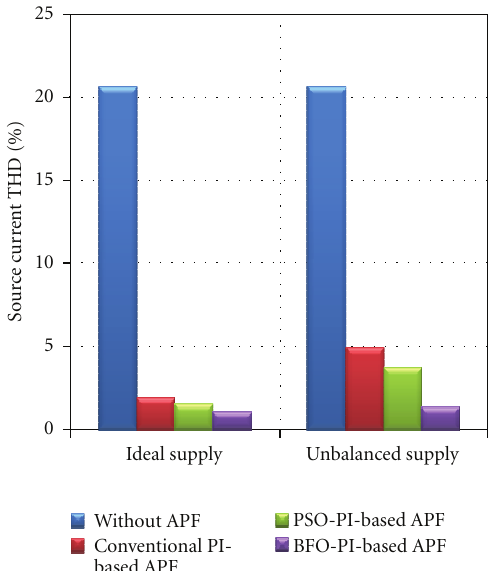
Figure 14: Comparison of THD in source